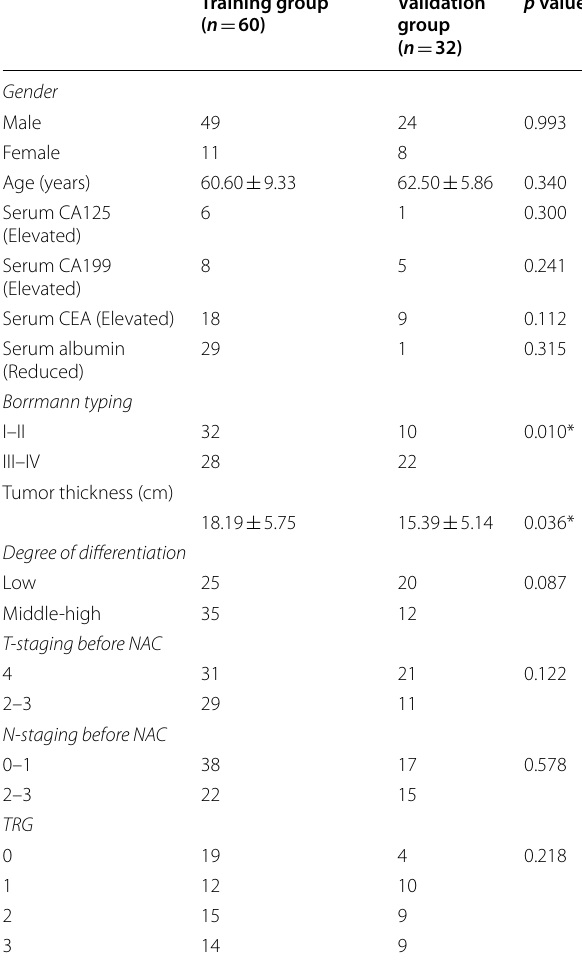
Table 1 Clinical characteristics of the enrolled patients in the training group and the external validation